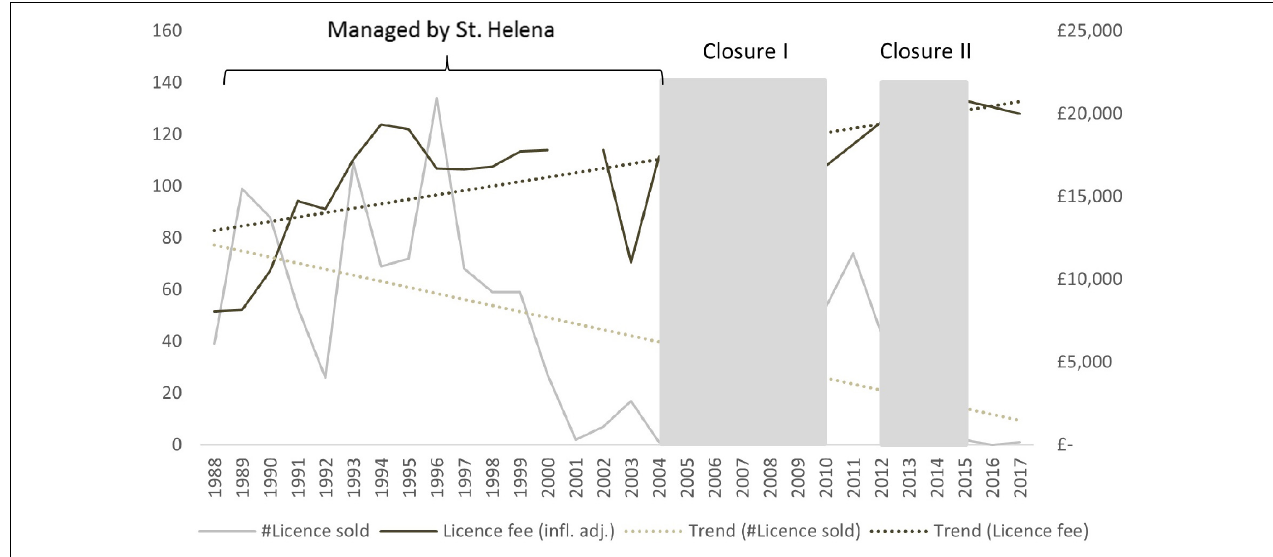
FIGURE 2 | The number of licenses sold and license fee (in GBP-2017 values) for harvesting the EEZ of Ascension Island (1988–2017) (including linear trend